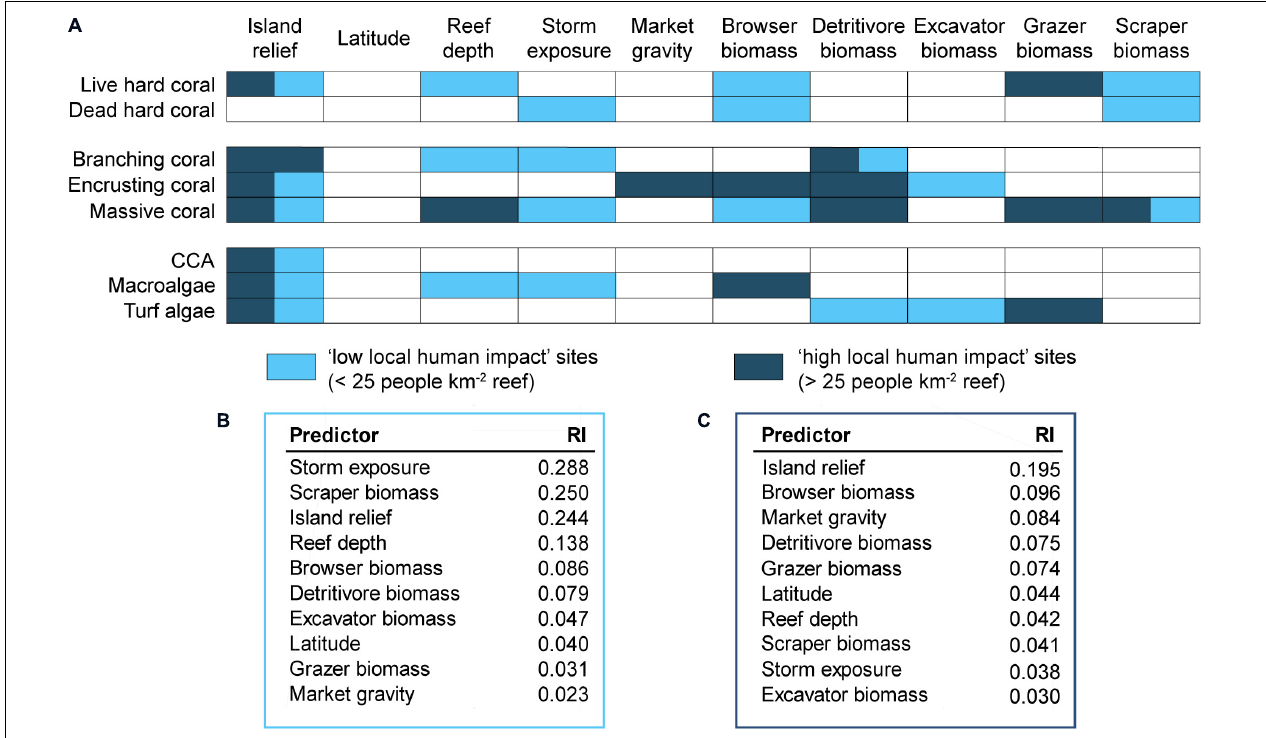
FIGURE 3 | (A) Outcome of model selection procedures: coloured boxes indicate that the predictor was selected for best-fit models (i.e., those with Akaike weight > 0.05) at sites subject to low and/or high levels of local impacts. The overall mean relative importance of each predictor (RI–based on total Akaike weight of all models including that predictor) in explaining the benthic response variables is shown separately for sites subject to (B) low and (C) high local impacts. Note: though model selection was limited to four predictors per model, all predictors included in models with Akaike weight > 0.05 are shown meaning there may be more than four predictors shown within one impact level for a response variable. Model outputs for best-fit models are available in Supplementary Table 5